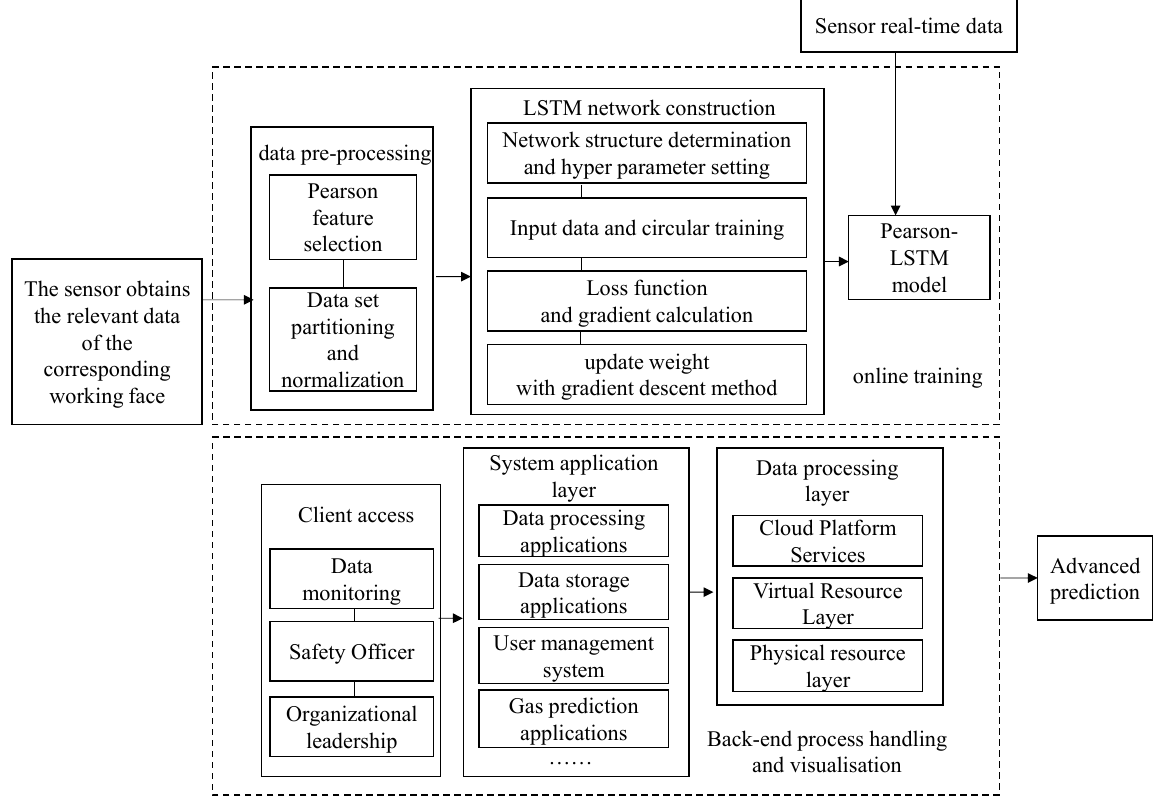
Figure 13. Advanced prediction scheme of gas concentration in the working face.